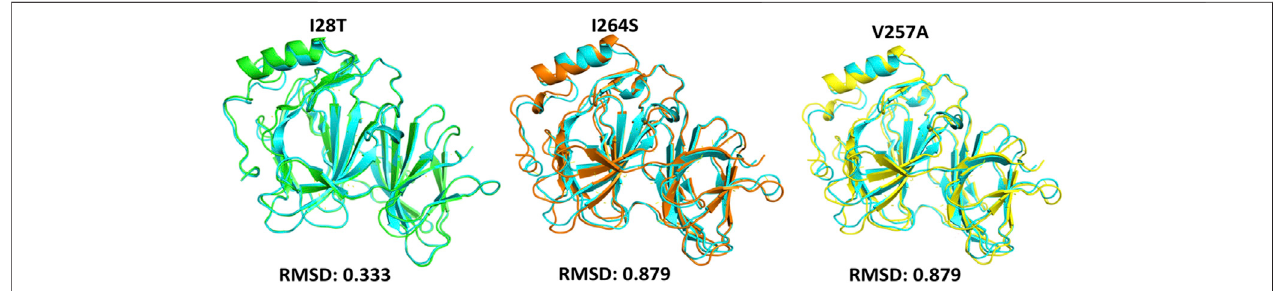
FIGURE 3 | Superimposed structure of WT PIR protein (cyan) with mutants I28T (green), I264S (orange), and V257A (yellow). The RMSD of each superimposition was reported to be 0.333 Å (I28T) and 0.879 Å (I264S,